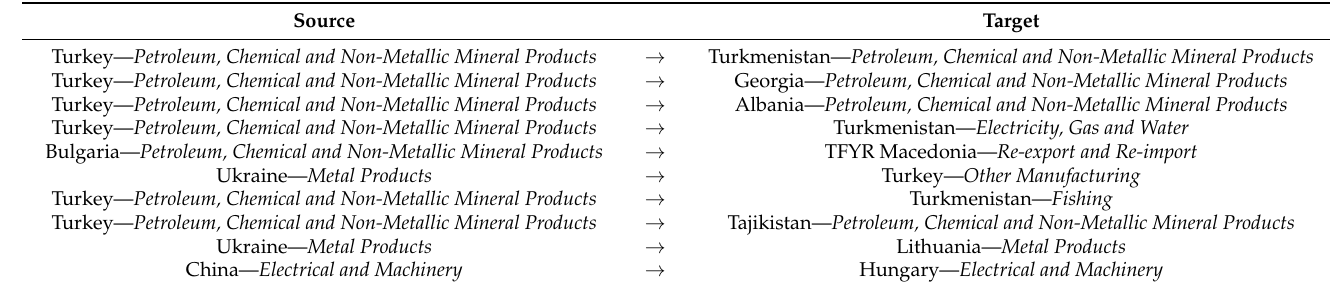
Table 4. Top 10 EGSR flow relationships at the sectoral level. Source Target